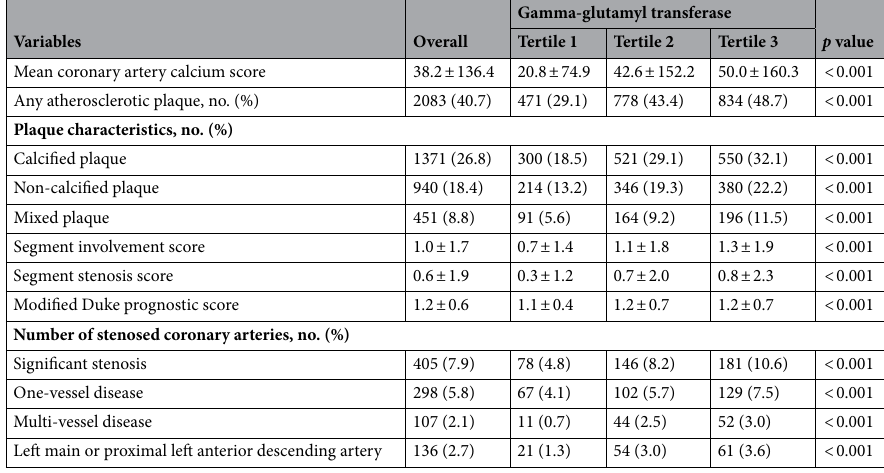
Table 2. Comparison of coronary computed tomography angiographic findings according to the tertiles of gamma-glutamyltransferase. Values are presented as mean ± standard deviation or number (%). Pearson’s chi-square test or Fisher’s exact test were used for categorical variables and one-way analysis of variance or Kruskal–Wallis test were used for numerical variables.